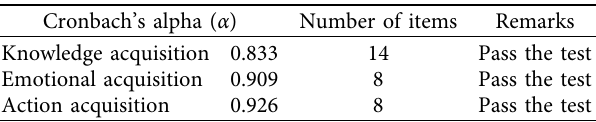
Figure 2: A scenario of a rainforest from VR glasses. Table 1: Reliability coefficients of each dimension in the sense of the acquisition scale of environmental